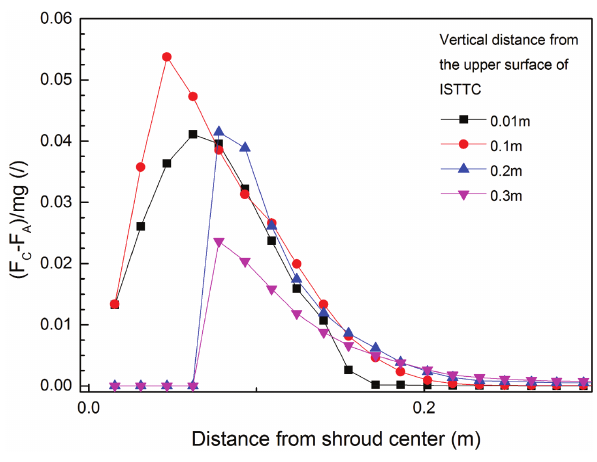
Figure 13: The force ratio between centripetal force and gravity in swirling flow from ISTTC ( θ = 45°).